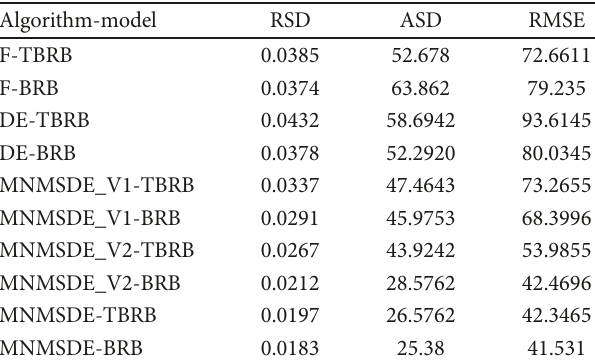
Table 3: Comparison of RSD, ASD, and RMSE.